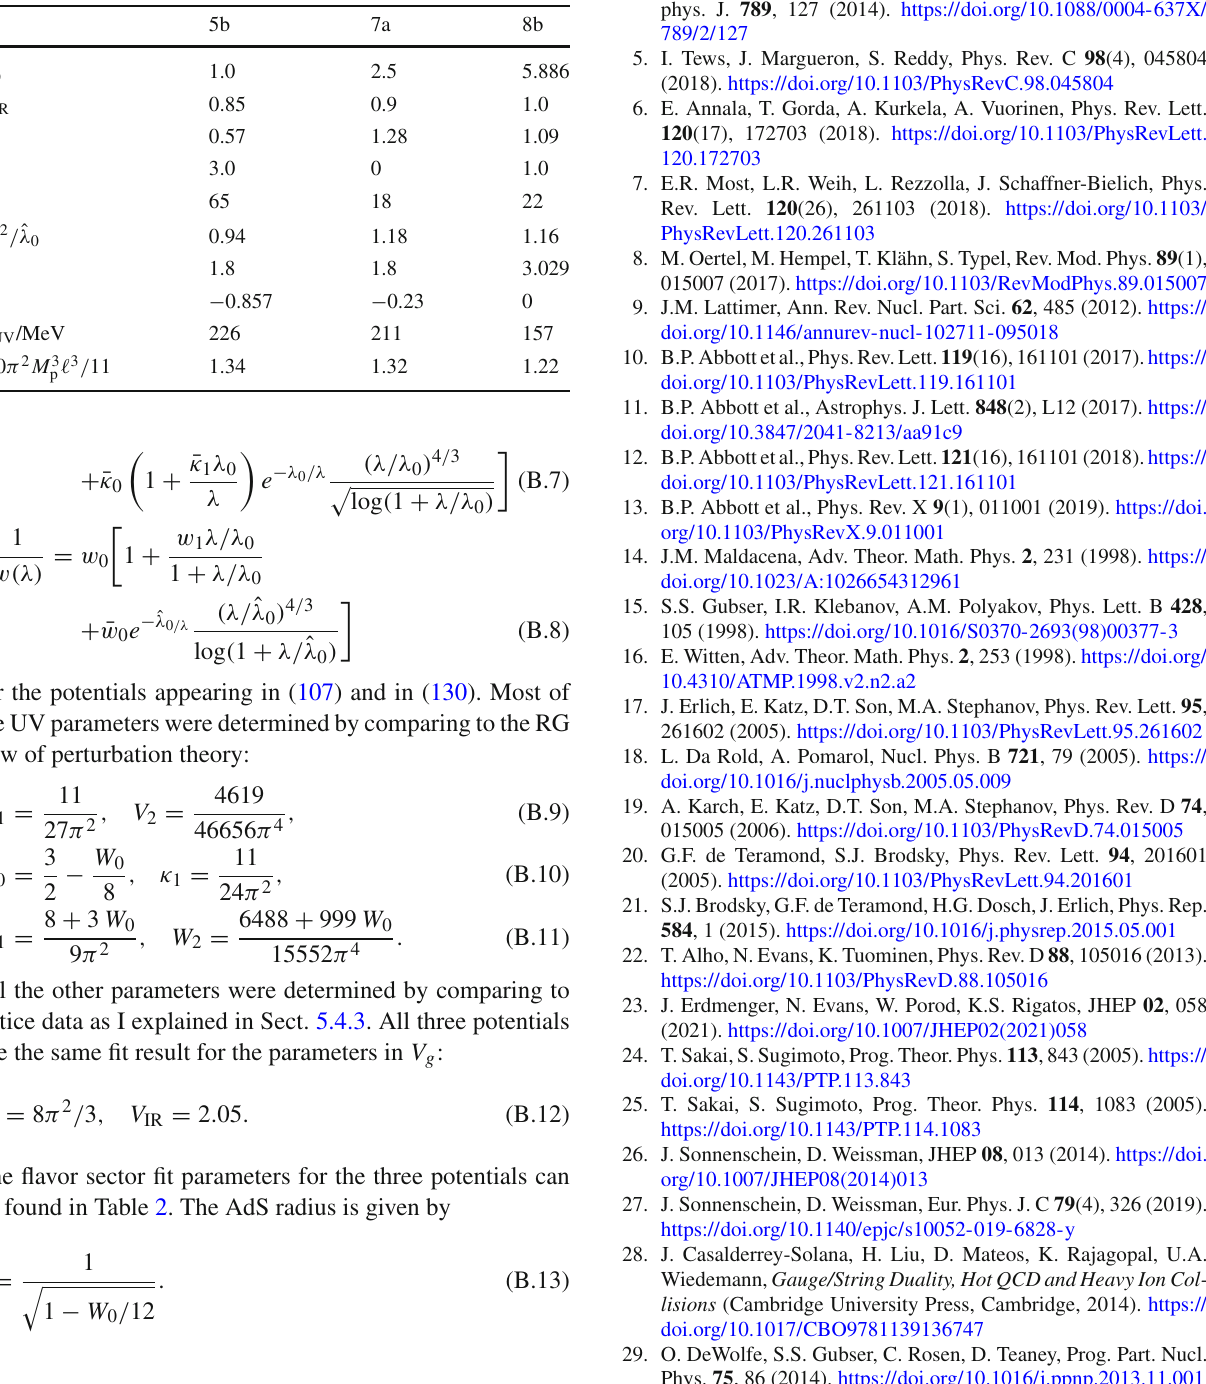
Table 2 The parameters of the potentials 5b, 7a, and